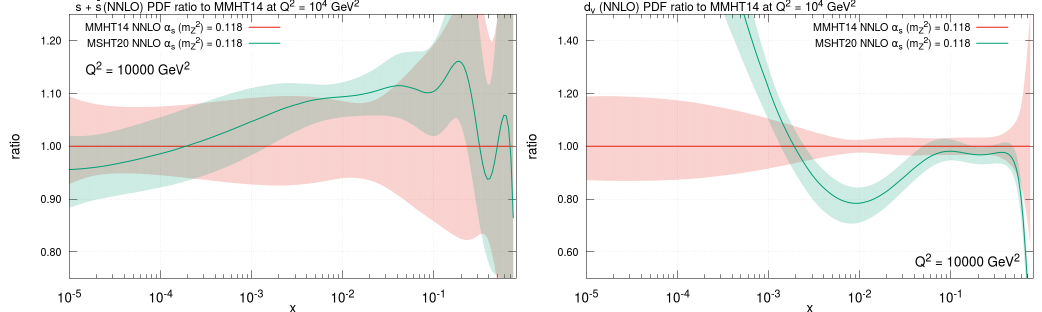
Figure 5: The MSHT20 strange quark sum (left) and down valence quark (right) compared to